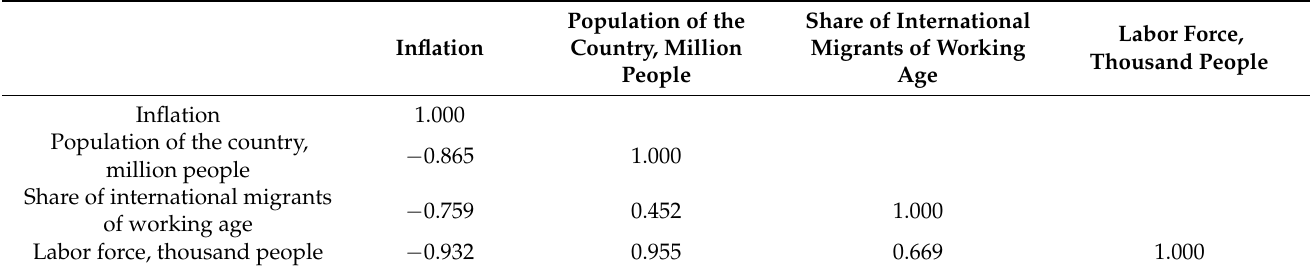
Table 9. Results of correlation analysis of inflation and factors of demographic